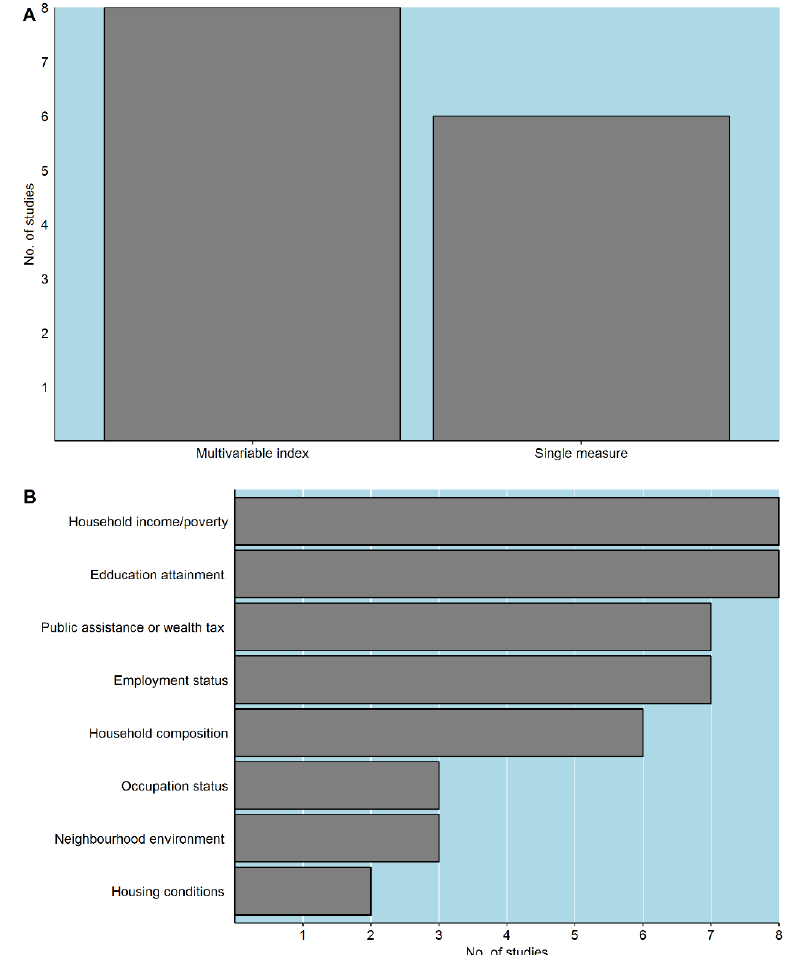
Figure 3. Measures of neighborhood socioeconomic deprivation used in the included studies: ( A ) No. of studies using single measures vs. multivariable indexes of neighborhood socioeconomic deprivation; ( B ) Variables included in the multivariable indexes of neighborhood socioeconomic deprivation.